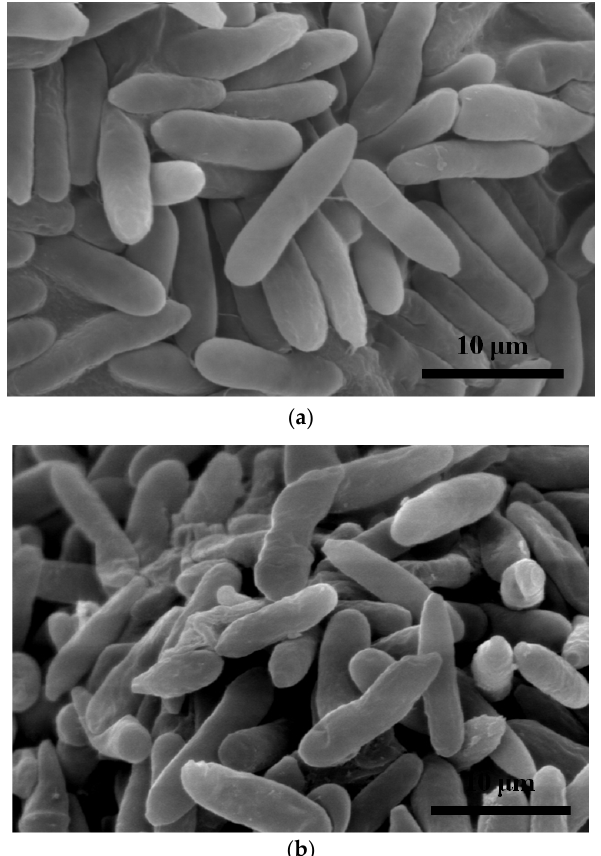
Figure 10. SEM micrographs of C. gloeosporioides treated with different Ag particle samples: ( a ) glass (control) and ( b ) 1.2 μm.